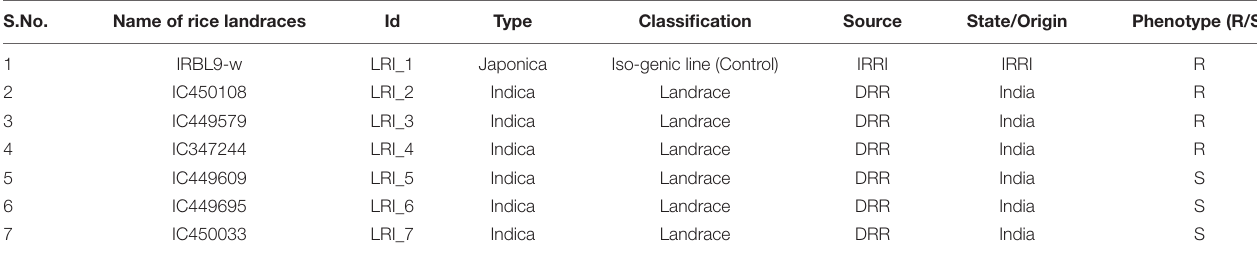
TABLE 1 | Rice landraces sourced from NBPGR and their reaction to Magnaporthe oryzae at uniform blast nursery (UBN), Hazaribag selected for allele mining of Pi9 gene. S.No.